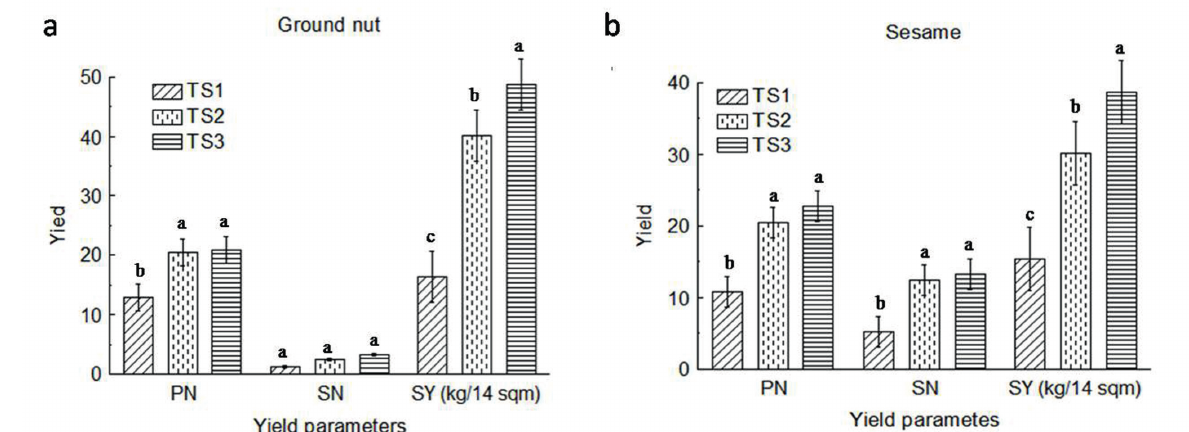
Figure 2 - Use of bio-controlling agent in agricultural field. a : Effect of B. cereus IB311 on ground nut ( Arachis hypogaea ) production in field trial experiments. b : Effect of B. cereus IB311 on sesame ( Sesamum indicum ) production in field trial experiments. PN- average pod number per plant, SN- average seed number per pod, SY- seed yield per experimental plot. TS1- untreated experimental plots (negative control), TS2- experimental plots treated with 100% recommended dose of NPK (positive control), TS3- experimental plots treated with B. cereus